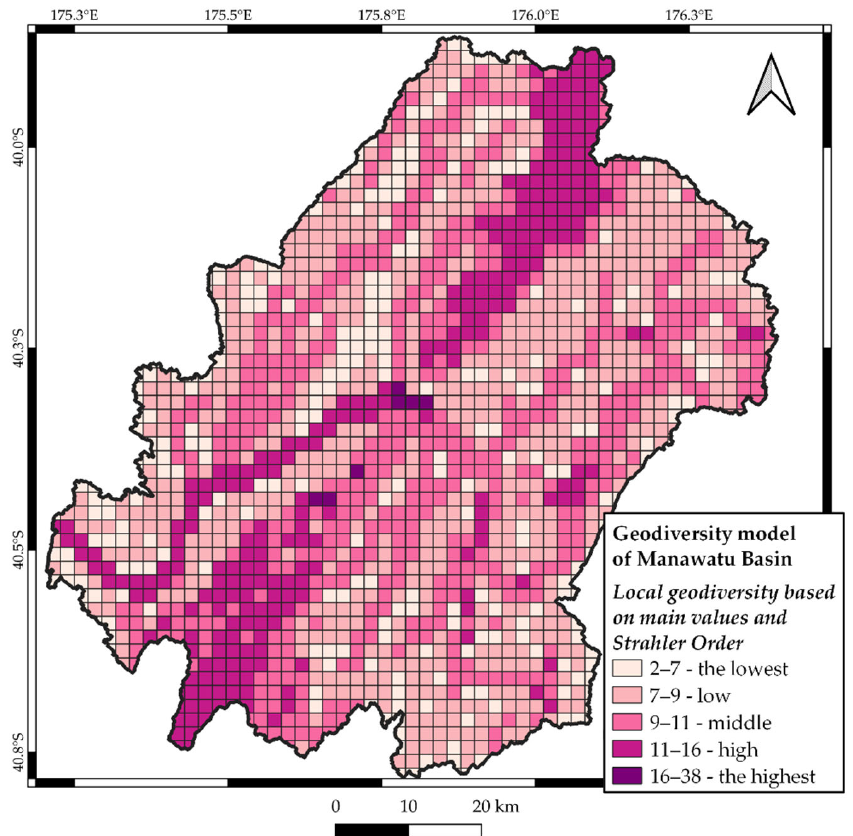
Figure 7. Geodiversity model of Manawatu Basin improved with hydrological values based on the model of Strahler order. Values were weighted specifically for local perspectives to highlight the locations of interest.